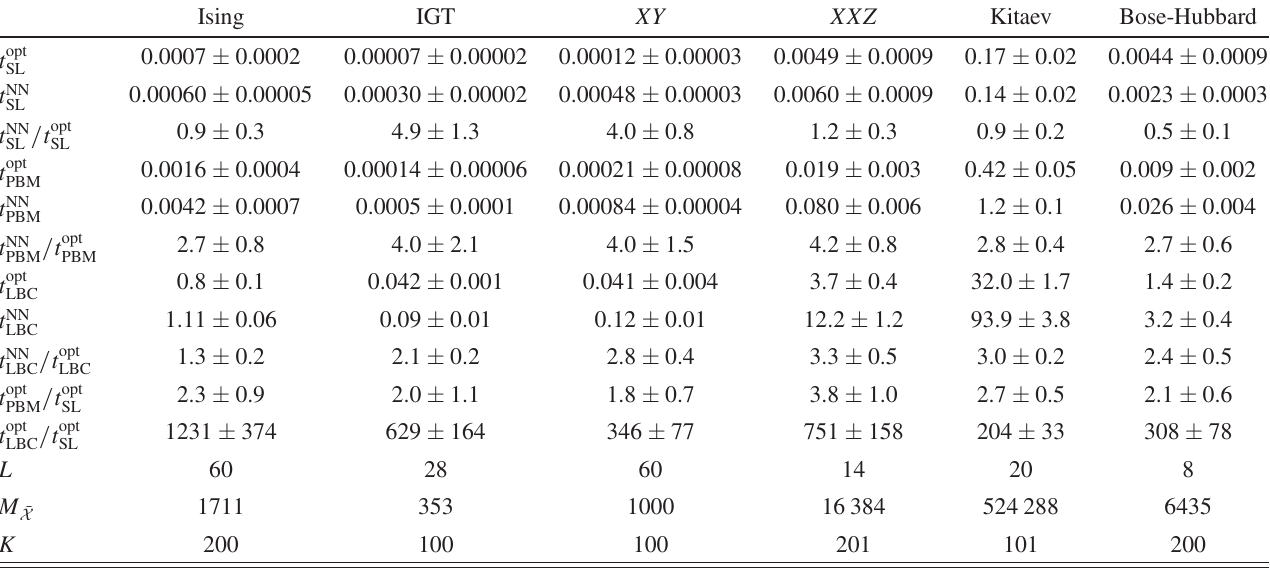
TABLE I. Measured computation times in seconds associated with constructing and evaluating optimal models, t opt , or training an NN of minimal size (one hidden layer with a single node) for a single epoch, t NN , for all three methods and six systems discussed in the main text (see Sec. IV). The linear system size L and the corresponding number of unique samples M ¯ X as well as the number of sampled values of the tuning parameter K for each system are also reported. The construction and evaluation of the optimal models yield the optimal predictions, optimal indicator, and optimal loss value. A training epoch is comprised of evaluating the NN at all M ¯ X unique samples, calculating the loss function, obtaining the gradient via backpropagation, and performing a single gradient step. For details on the NN architecture and training, see Appendix B. Note that, in LBC, t NN corresponds to K þ 1 times the computation time of a training LBC epoch for a single NN. All computation times are measured on a single CPU [Intel(R) Xeon(R) CPU E5-2630 v4 @ 2.20 GHz], and garbage collection times are subtracted from the total run-time. To gather statistics, for each method and system computations are run for 20 h. If 10 5 independent runs are completed in less than 20 h, the computations are stopped prematurely. The error corresponds to the observed standard